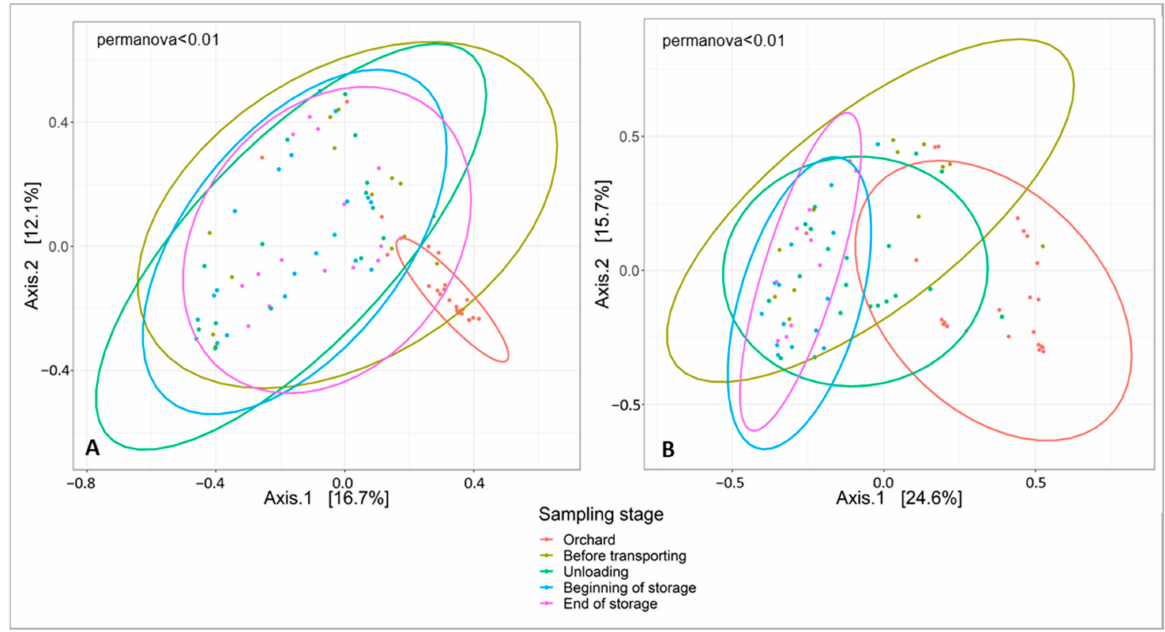
Figure 6. Principal coordinate analysis (PCoA) of fungal ( A ) and bacterial ( B ) populations associated to the surface of cider-apples sampled at the five post-harvest stages based on the beta diversity metric Bray